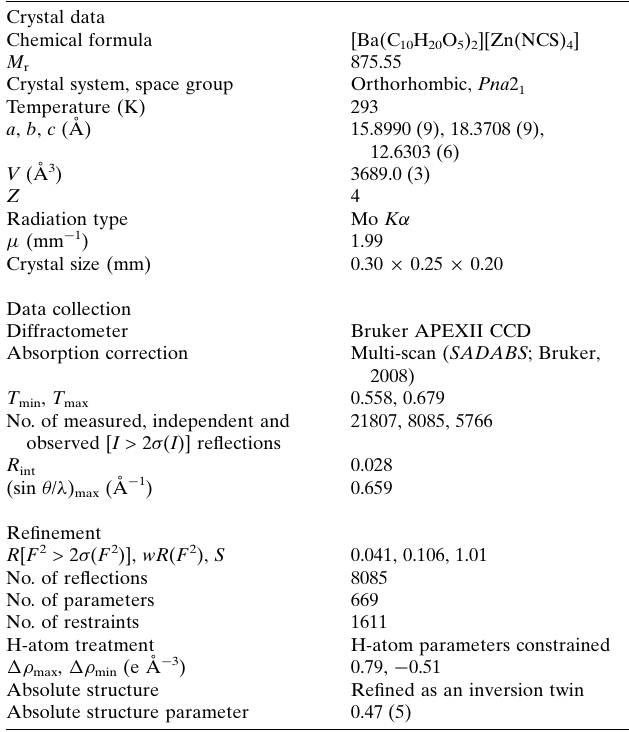
Table 2 Experimental details. Crystal data Chemical formula